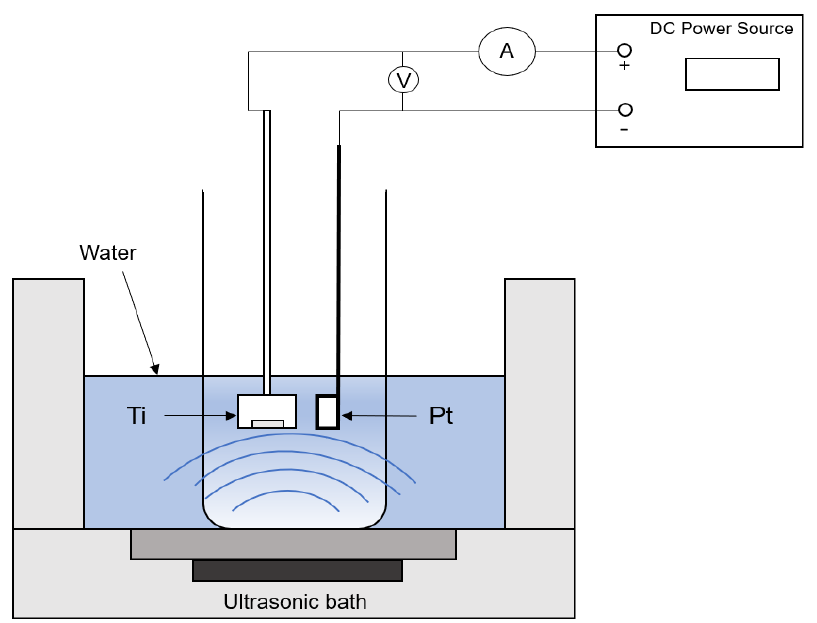
Figure 13. Experimental set-up for anodization of titanium by ultrasonic treatment; representation modified from [45].